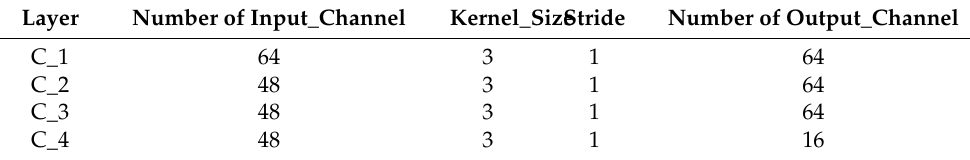
Table 1. Convolutional parameter setting in the information distillation module.